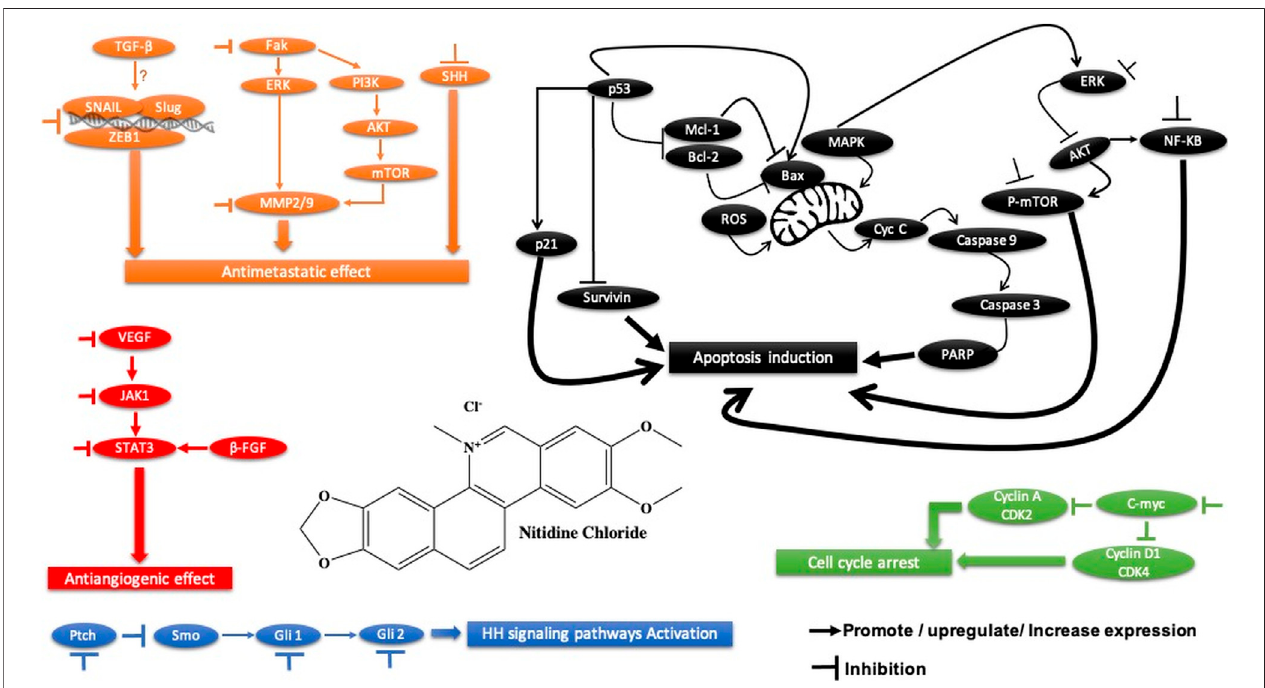
FIGURE 2 | Main mechanism of nitidine chloride against cancer.